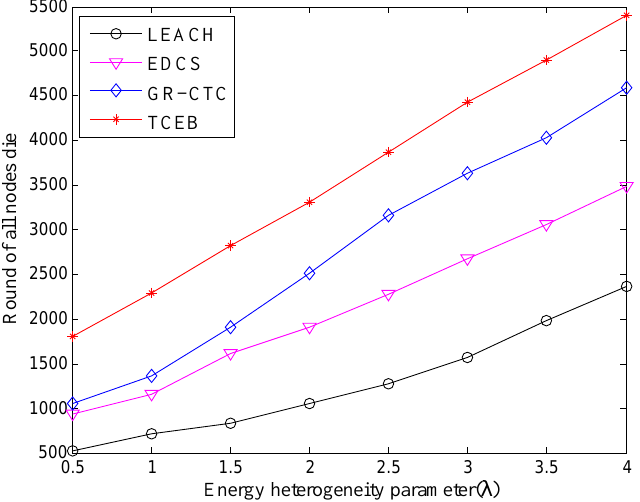
Figure 10. The comparison of whole lifetime under different energy heterogeneity factor ( n = 200 )